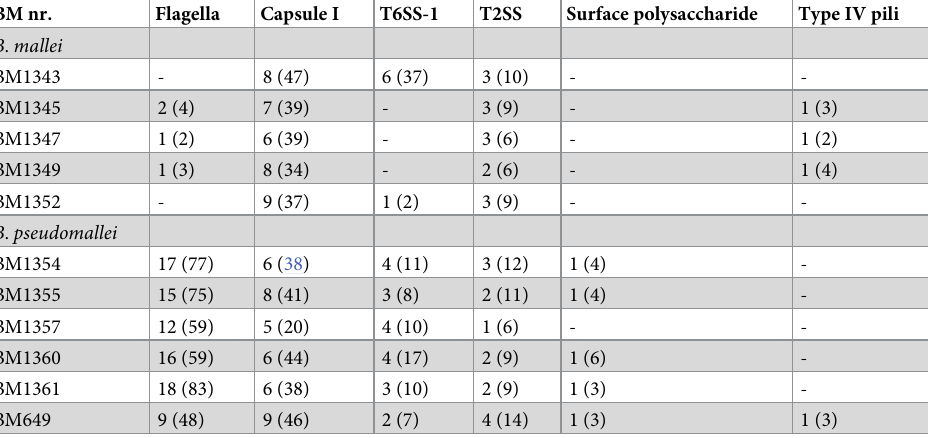
Table 9. The number of proteins and peptides (in parentheses) identified for each virulence factor. BM